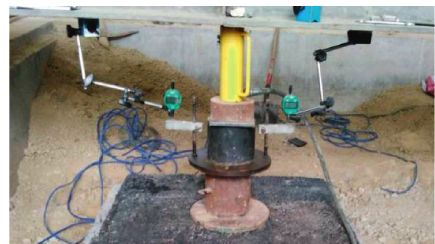
Figure 11: The equipment of the bearing plate method.